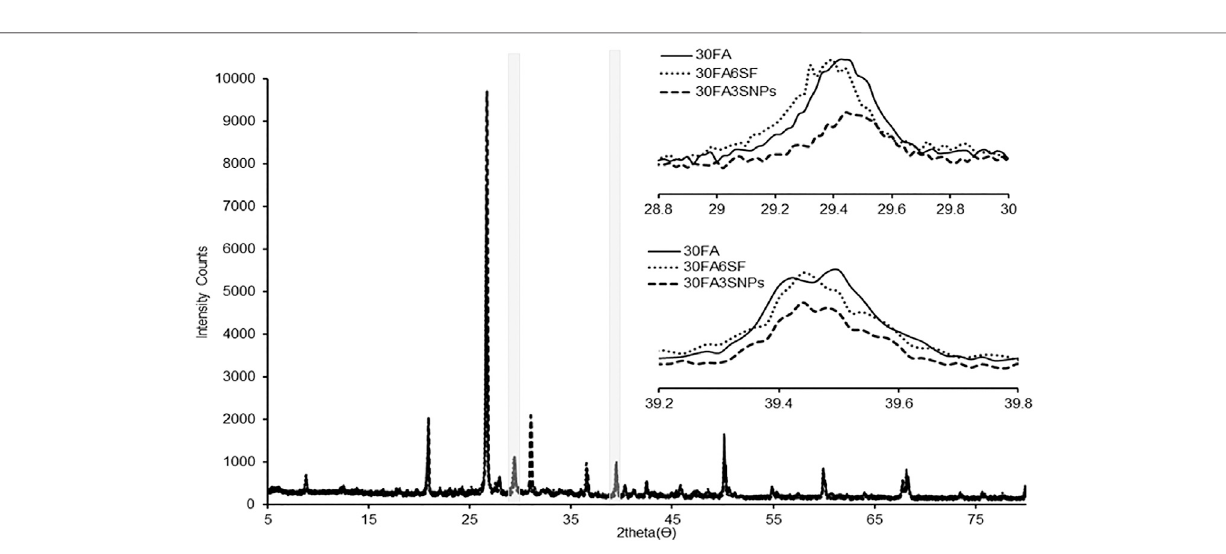
Frontiers in Built Environment |